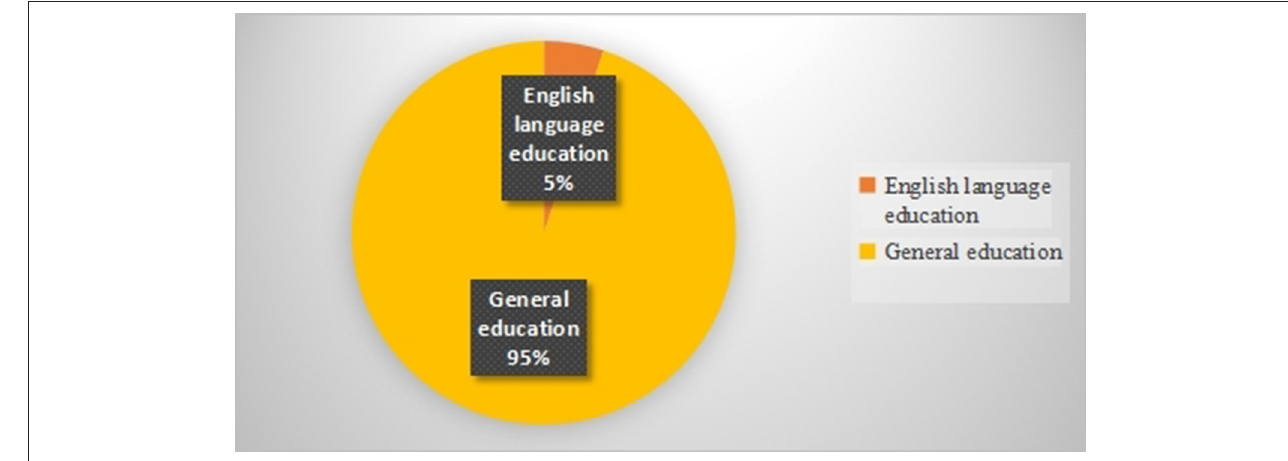
FIGURE 2 | Educational contexts.